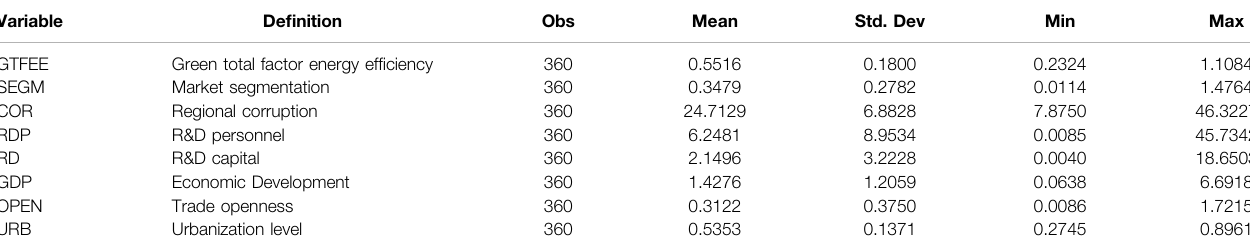
TABLE 1 | The variables description.